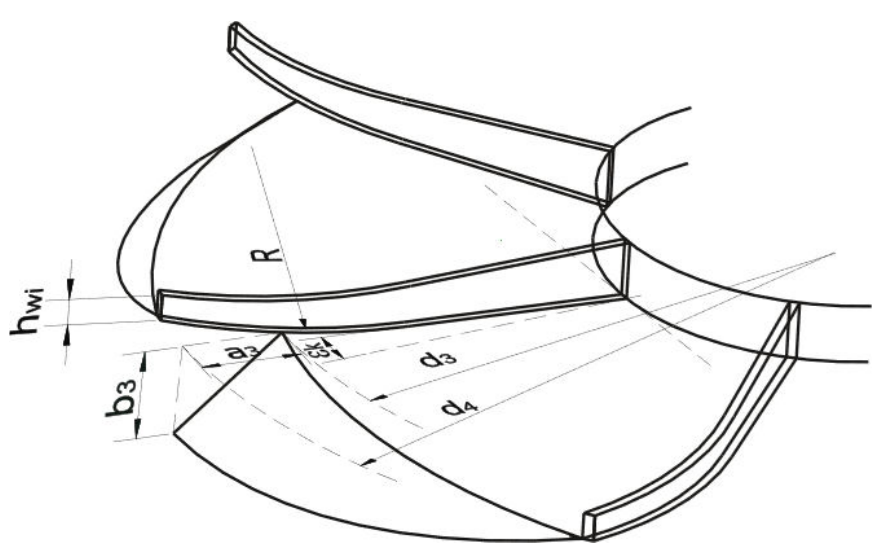
Figure 6. Characteristic dimensions of the guide vanes with the crossover shaped as a spherical surface. Table 1. Characteristic dimensions of the impeller of the model pump (Figure 5). No.